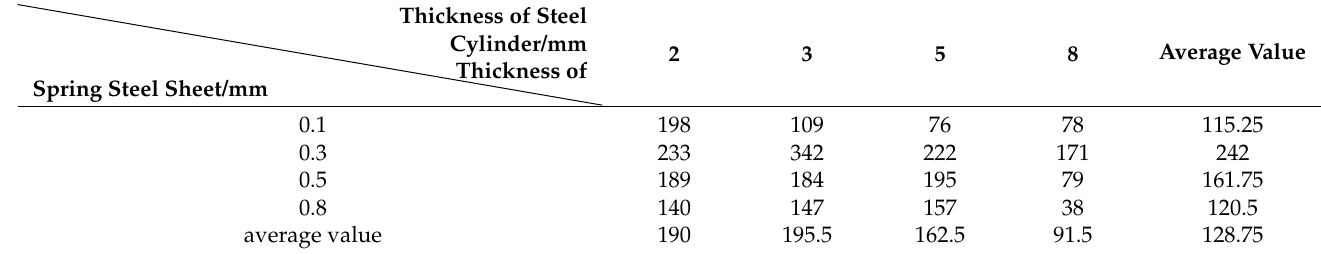
Table 2. The average strain values of three tests of each sensor type.